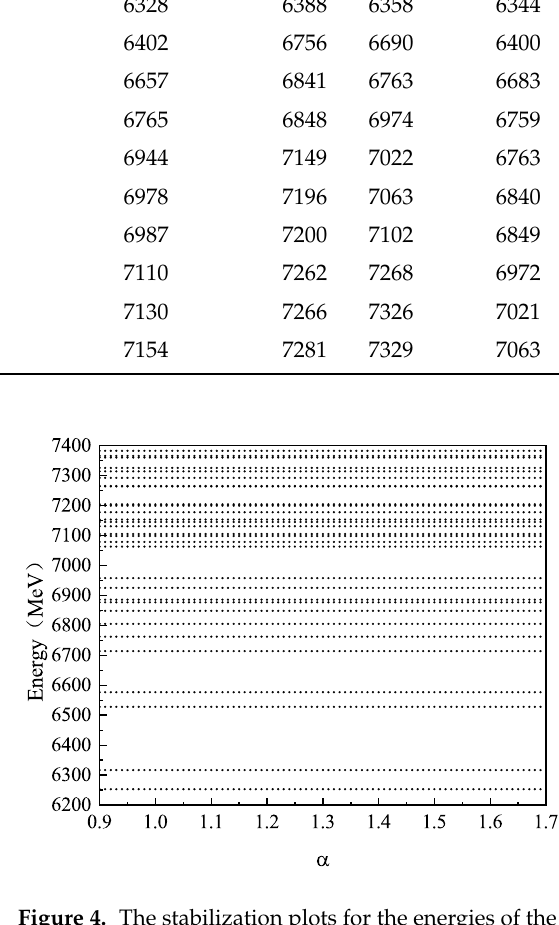
+ ( DA ) 0 ) with respect to the scaling factor α 2 1